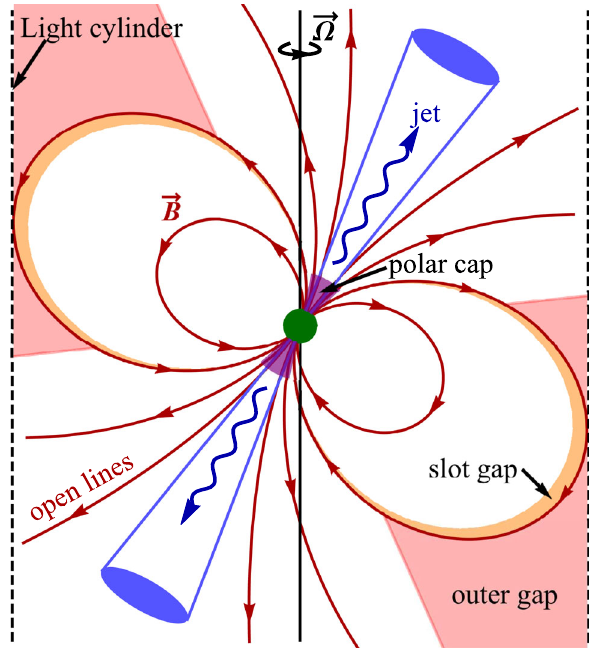
Fig. 1 A schematic illustration of the pulsar magnetosphere